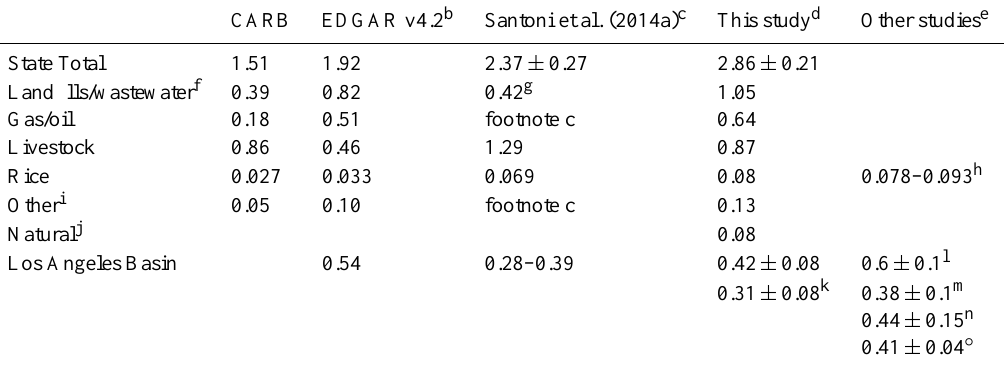
Table 2. Methane emissions in California a .